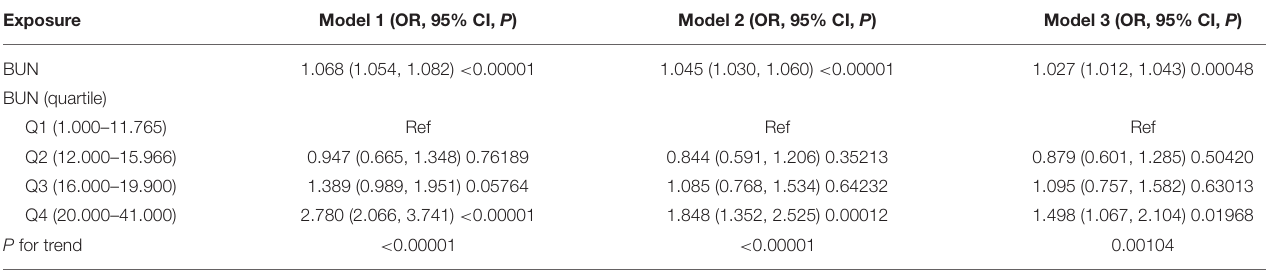
TABLE 5 | The results of the multivariate analysis after excluding brain tumor patients with dialysis and (or) renal failure. Exposure Model 1 (OR, 95% CI, P ) Model 2 (OR, 95% CI, P )